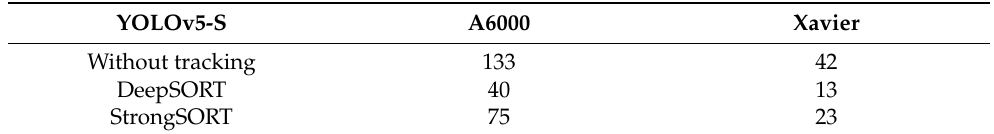
Table 8. The results of real-time performance (FPS) applied tracking algorithms DeepSORT and StrongSORT coupled with YOLOv5-S.